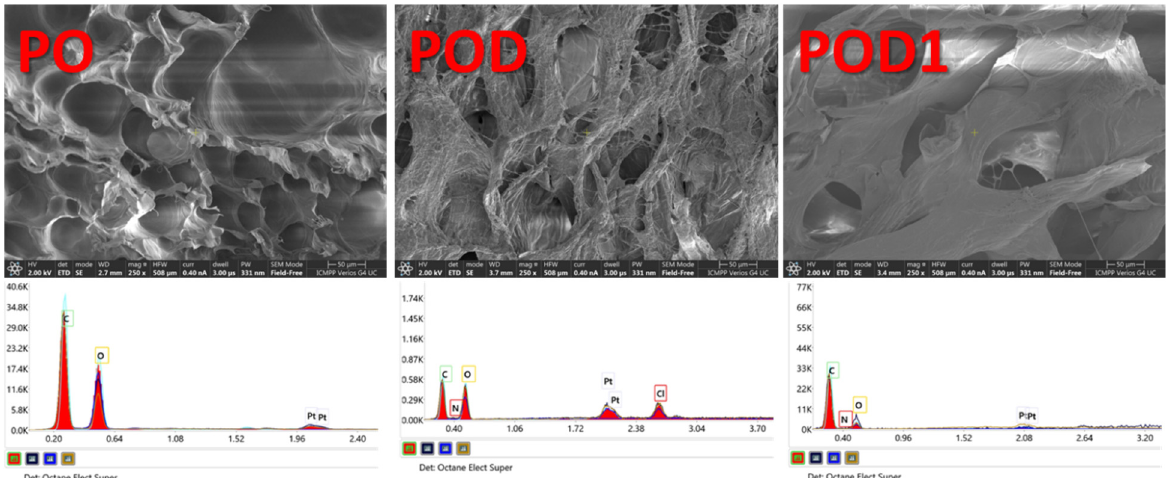
Figure 4. SEM micrographs of the internal morphology recorded for the three types of hydrogels and the corresponding EDAX spectra.